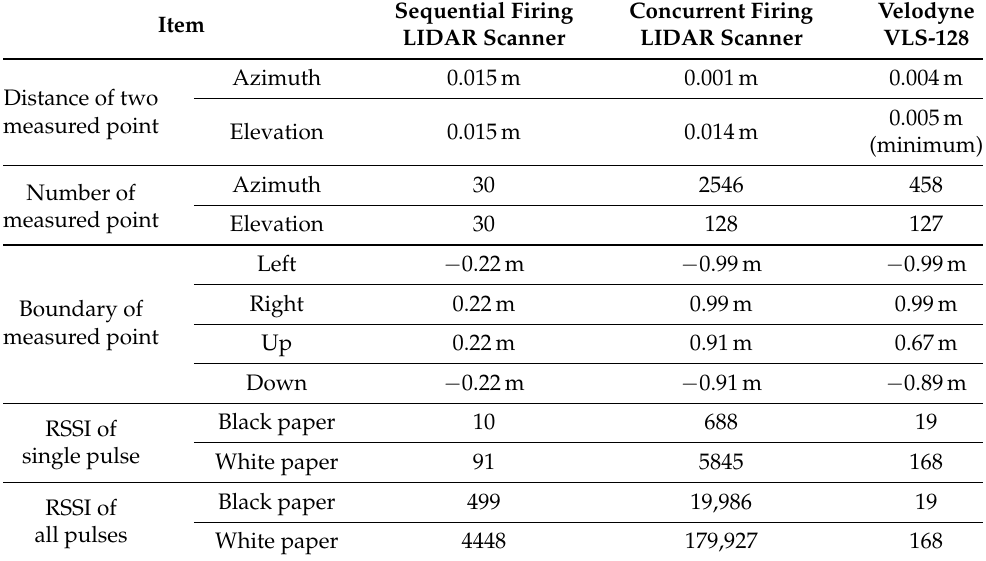
Table 5. Property comparison of the three LIDAR